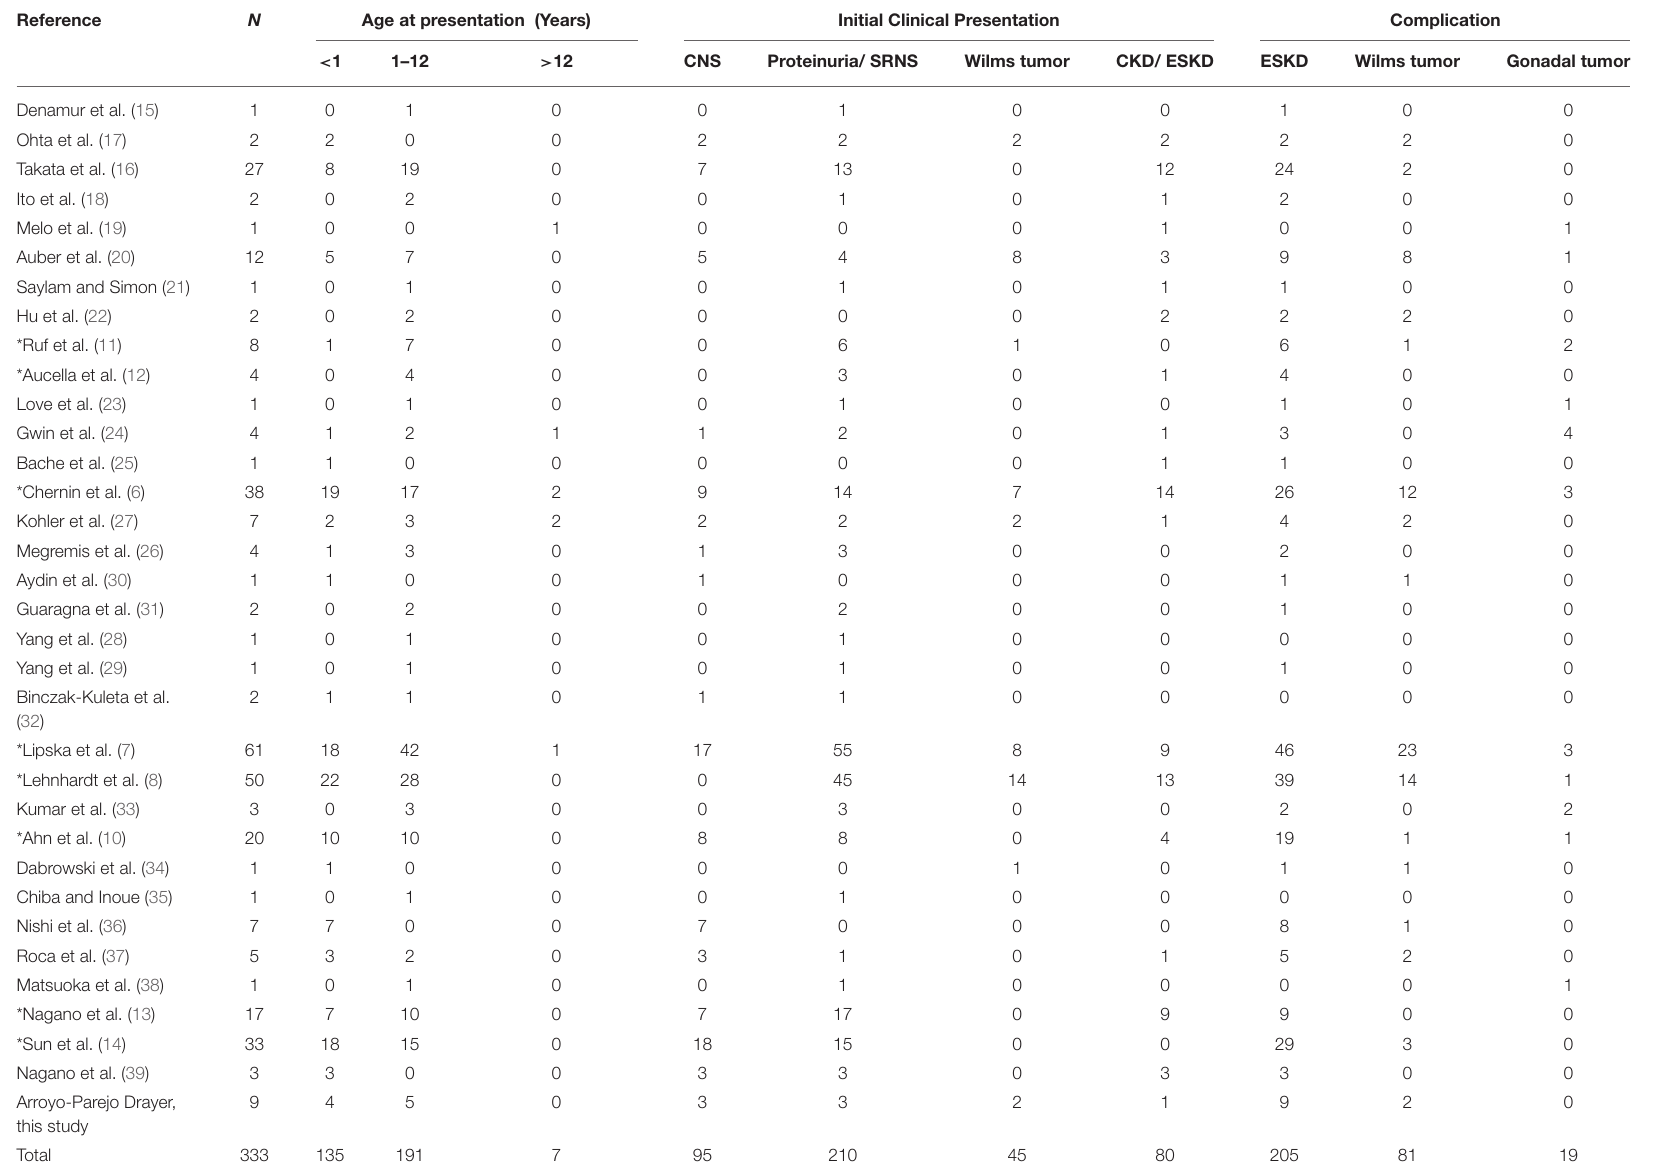
TABLE 2 | Compiled data on age of onset, presentation, and complications in WT1 glomerulopathy.